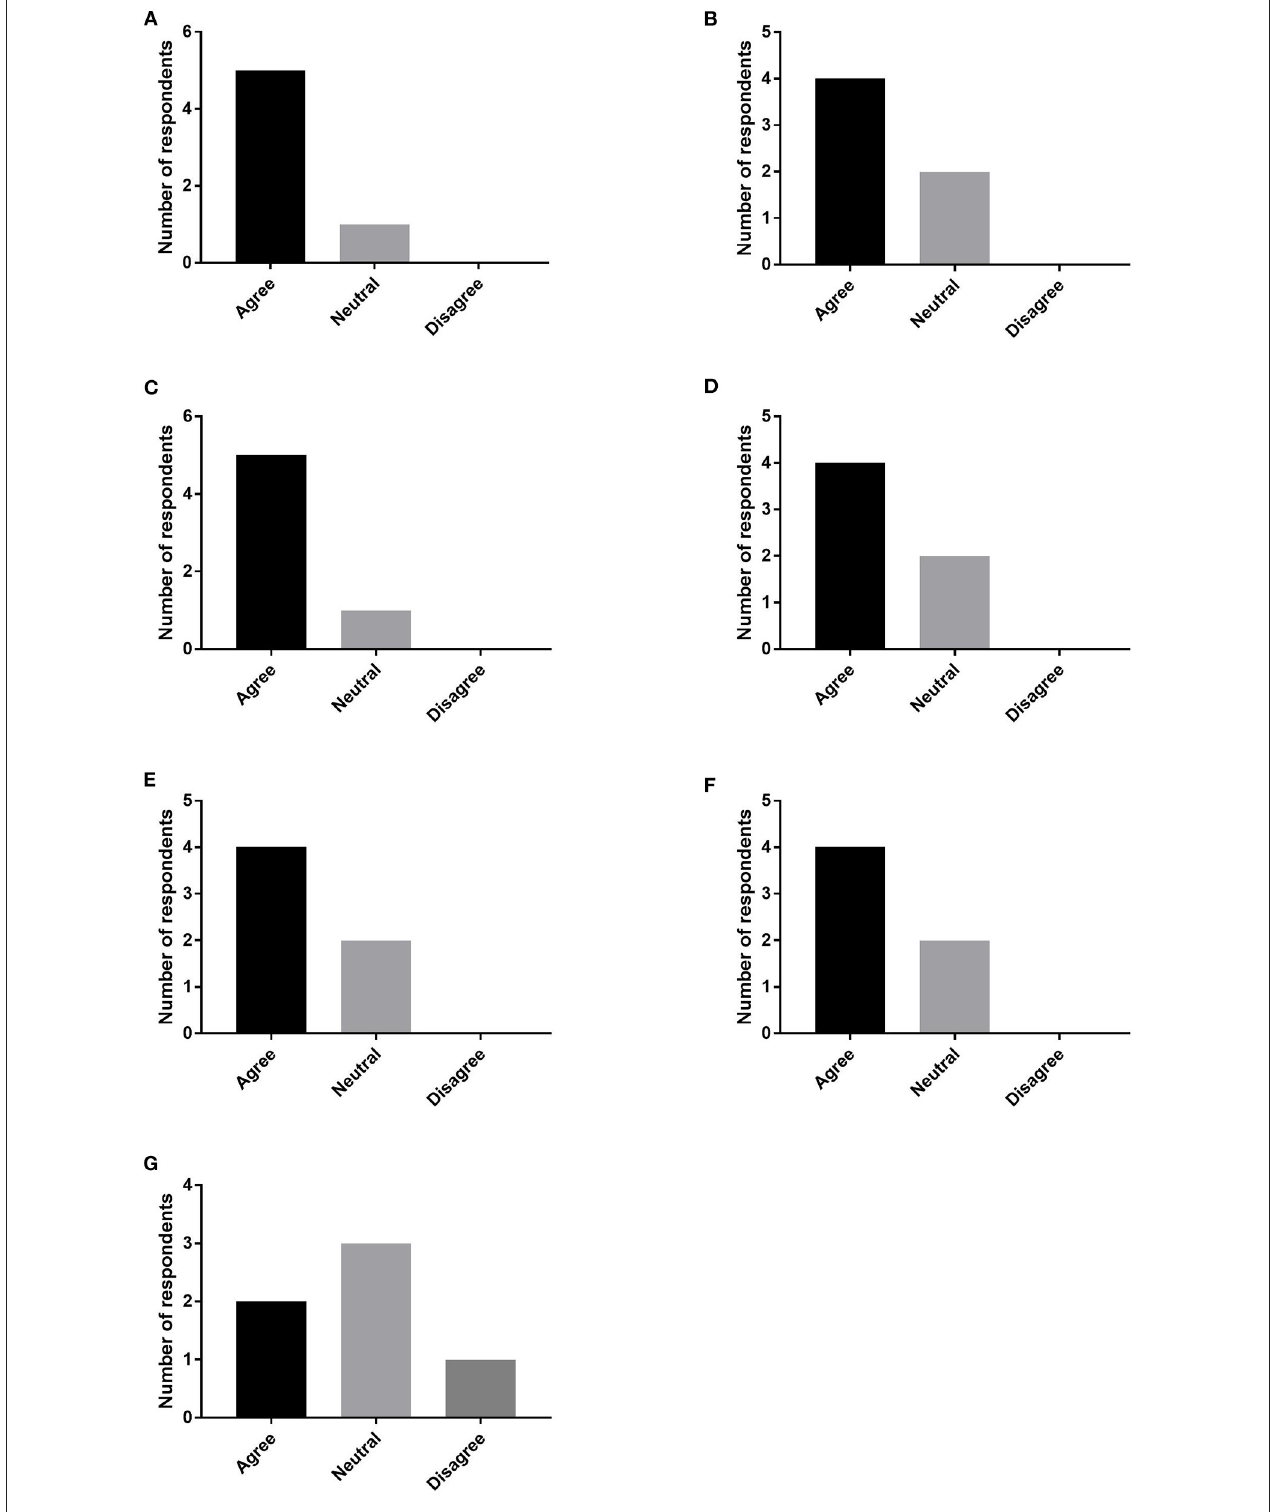
FIGURE 2 | Provider survey responses regarding satisfaction with MDC. Providers indicated whether they agreed, disagreed, or neither agreed or disagreed with the following statements: MDC (A) improved patient care, (B) streamlined patient care, (C) provided a comprehensive treatment plan, (D) provided more pain relief, (E) improved communication between colleagues, (F) improved fellow teaching, and (G) improved job satisfaction.